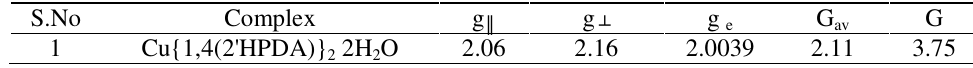
Table 2 . Electron spin resonance spectral